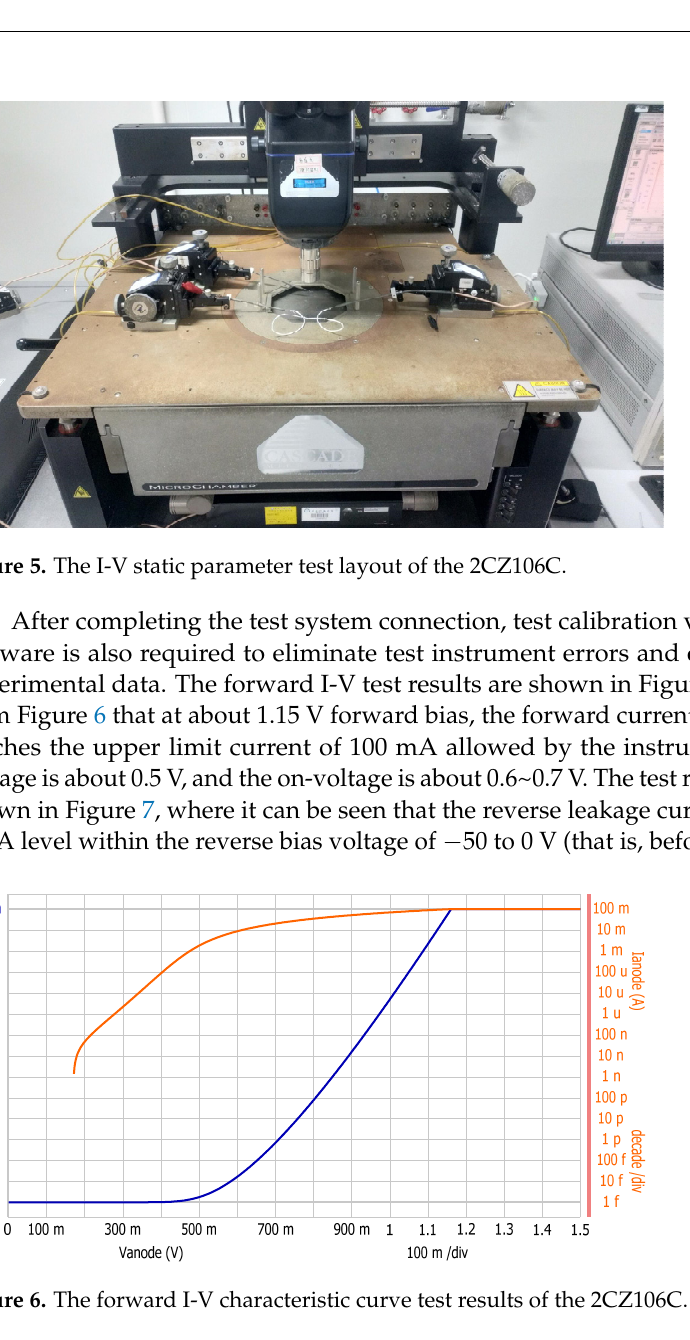
Figure 4. The I-V static parameter test system for diode.